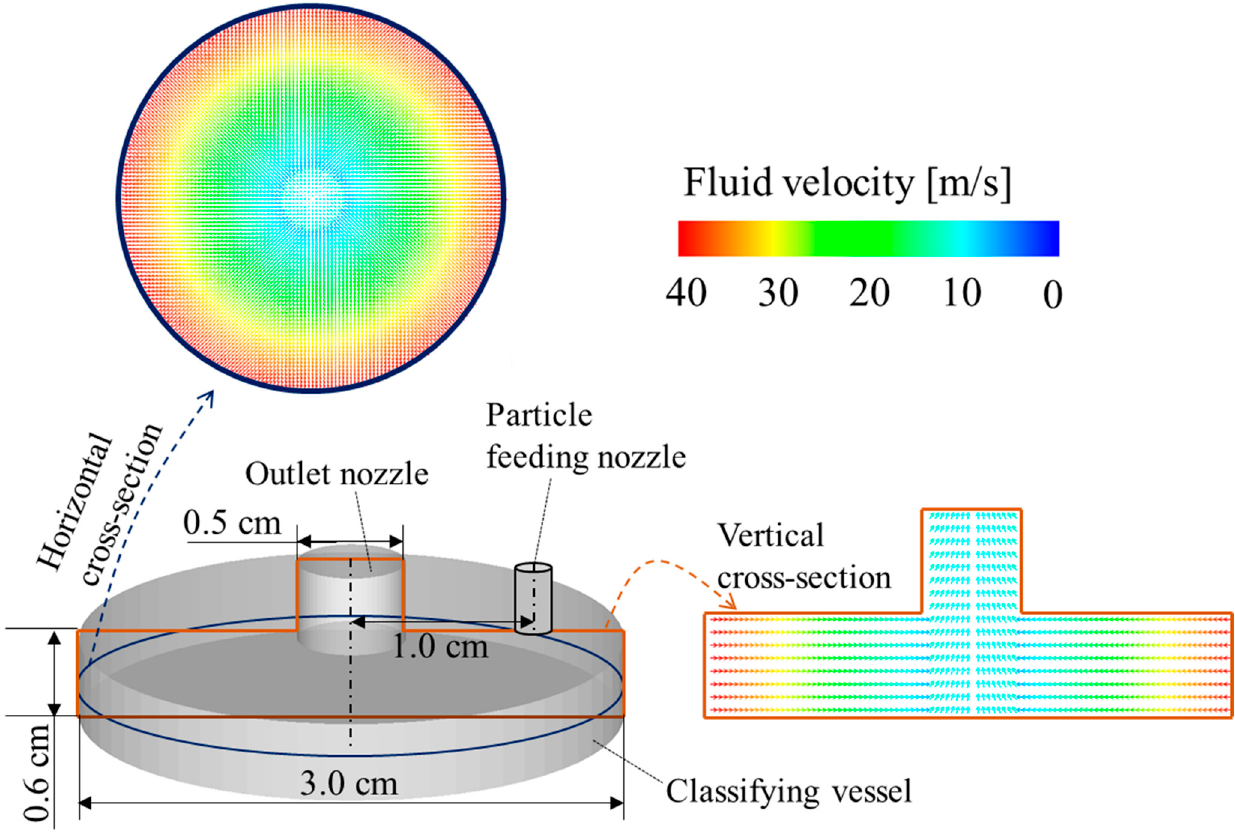
Figure 7. Geometry of the classifier and the flow field.